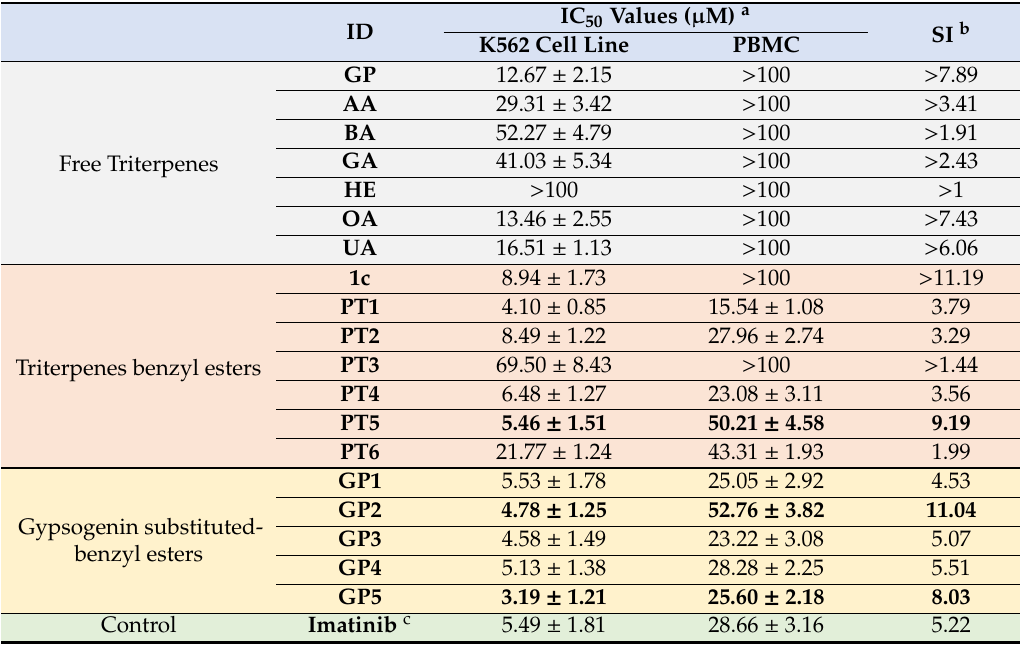
Table 1. The cytotoxic e ff ects of all compounds on K562 and peripheral blood mononuclear cells